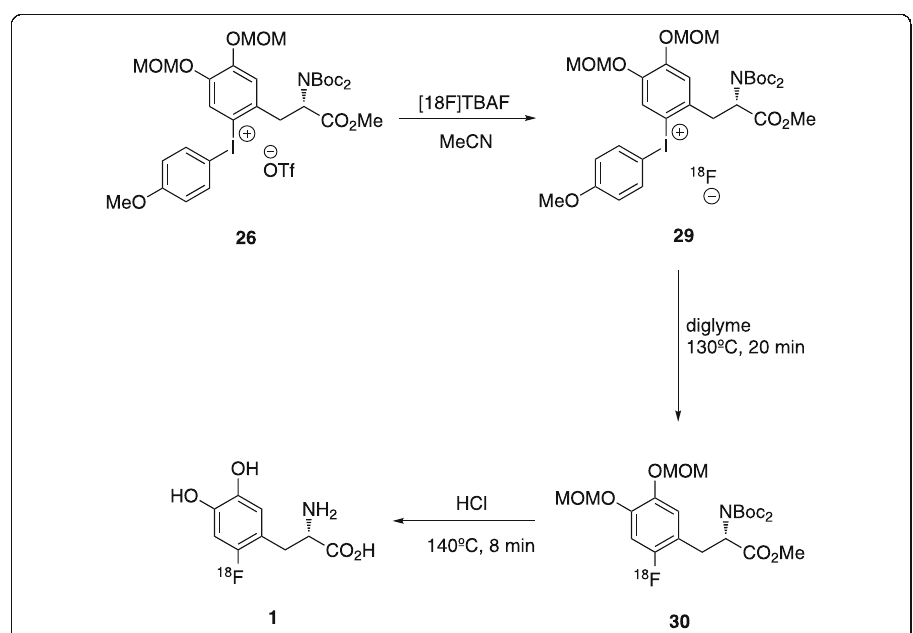
Fig. 10 Diaryliodonium triflate precursor for the synthesis of 6-[ 18 F]FDOPA by anion exchange followed by thermal decomposition (Edwards & Wirth, 2015)